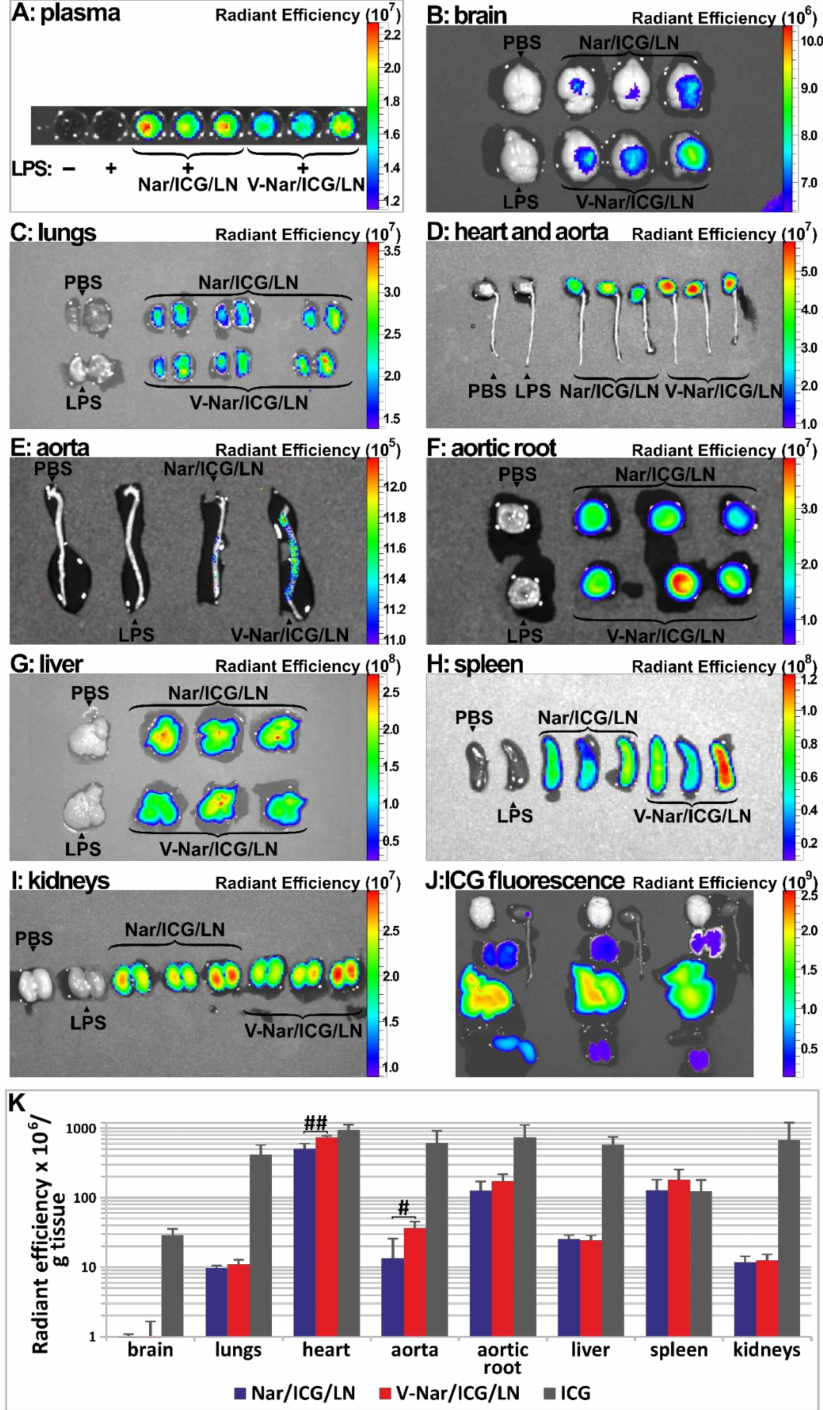
Figure 2. ( A – I ). Localization of ICG-labelled naringenin-loaded lipid nanoemulsions, either non-targeted (Nar / ICG / LN) or VCAM-1 targeted (V-Nar / ICG / LN), or of free ICG (ICG) in organs harvested from C57BL / 6 mice. Measurements were recorded 1 h after retroorbital administration in a model of LPS-induced inflammation with a IVIS Spectrum imaging system Caliper 200, by detection of ICG fluorescence λ ex = 745 nm and λ em = 820 nm. ( A ) plasma; ( B ) brain; ( C ) lungs; ( D ) heart and aorta; ( E ) aorta; ( F ) aortic root ; ( G ) liver; ( H ) spleen; ( I ) kidneys; ( J ) organs from animals in the free ICG group; ( K ) Comparative inter-organ quantification of fluorescence based on region-of-interest function of Living Image software; the values are shown as radiant e ffi ciency per tissue weight (g); # p < 0.05, ## p <